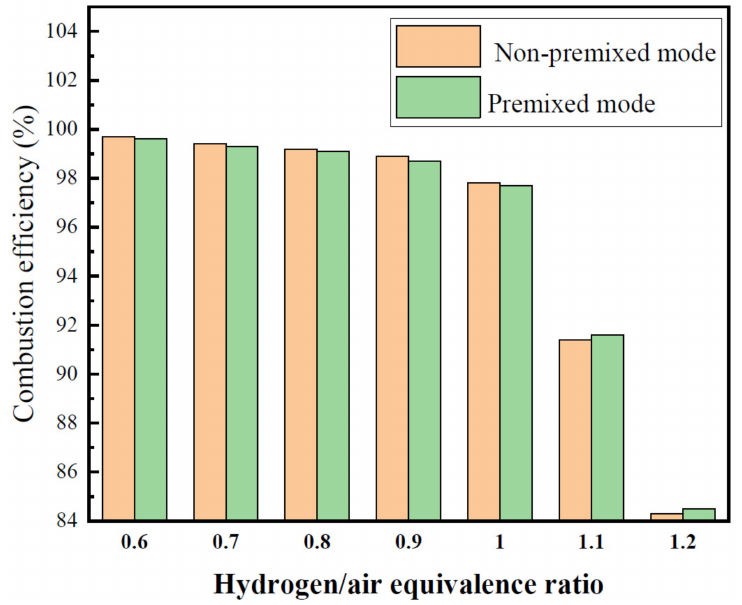
Figure 6. The combustion